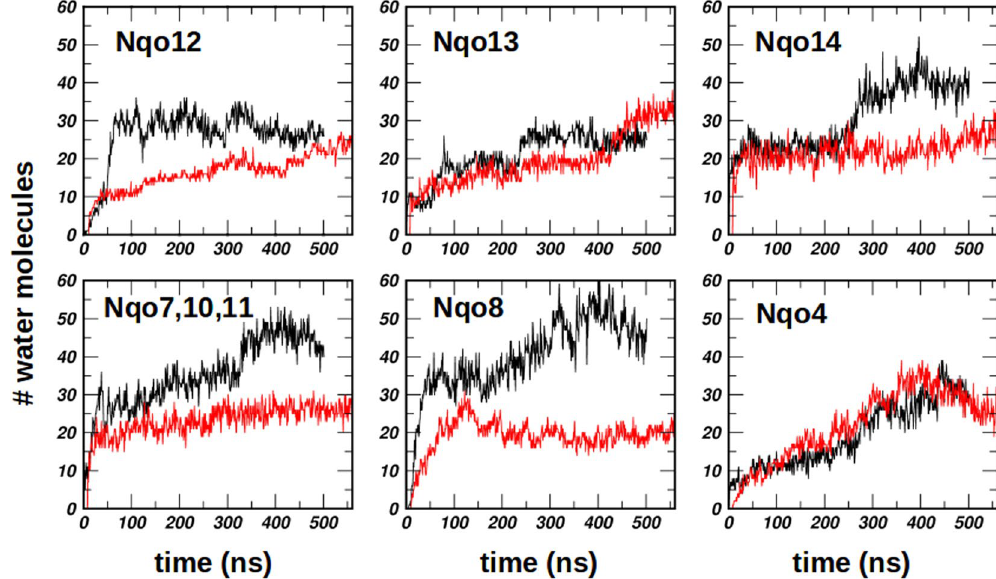
Figure 2. Hydration of the protein subunits based on simulations of setup I (black) and setup II (red) with Q ox and QH 2 , respectively (see also Table 1). Number of water molecules is plotted (ordinate) vs the simulation time (abscissa, in ns). Only water molecules (oxygen atom) within 4 Å of the selected amino acids are considered in the analysis (see Supplementary Table S1).